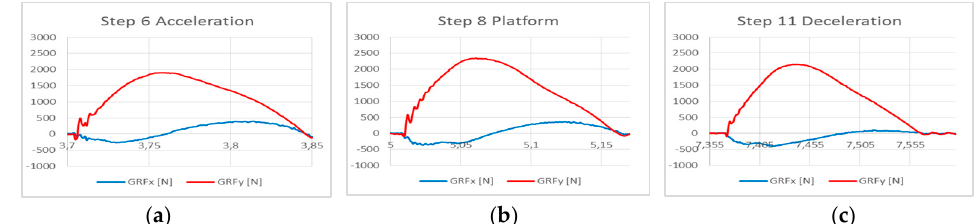
Figure 6. The application of iRPF for multiple-step GRF collection: In the Global Reference Frame collected over the 12 steps of a sprint test, including step 8 on the force platform, ( a ) step 6 during the acceleration phase, ( b ) step 8 over the force platform, ( c ) step 11 during the deceleration